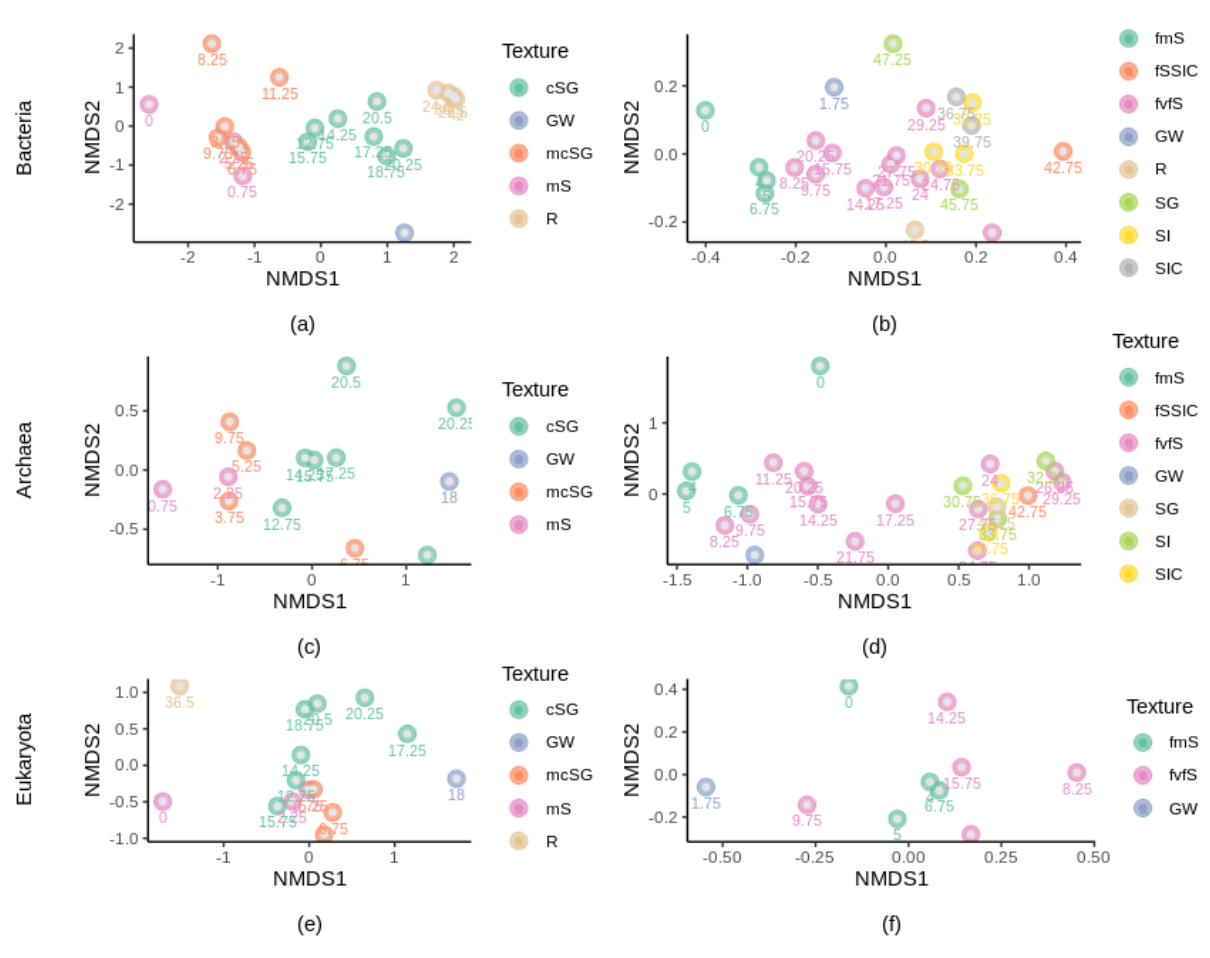
Table 1. Absolute abundances expressed in number of bacterial 16S rRNA gene copies per gram of geological material (copies g −1 ) detected in each sample. Only values with good quality thresholds are presented.